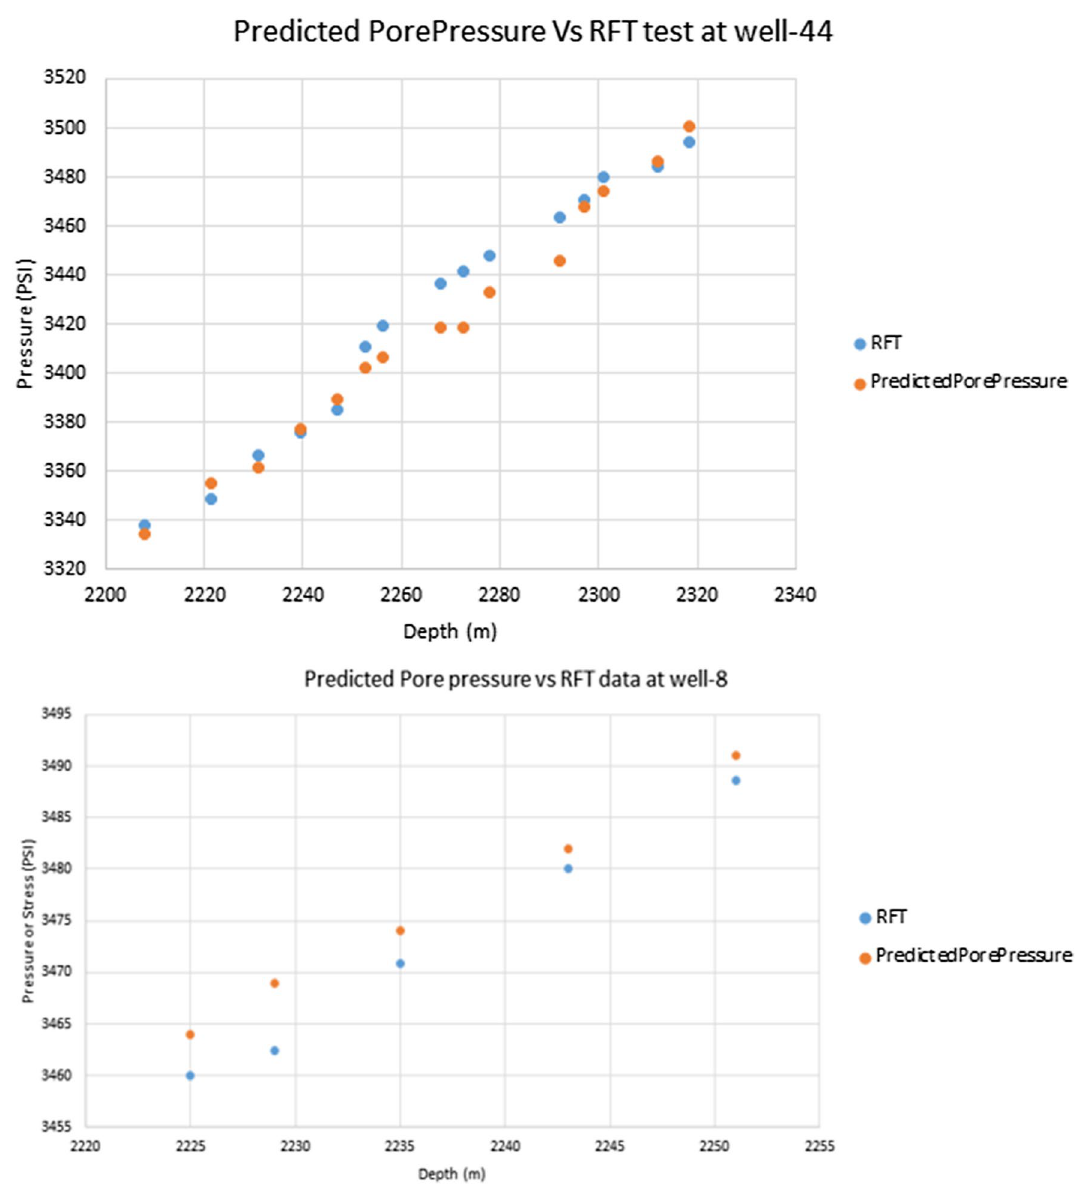
Fig. 4 The comparison of estimated pore pressure values (red spots) and the RFT values (blue spots) in well no. 44 and well no.